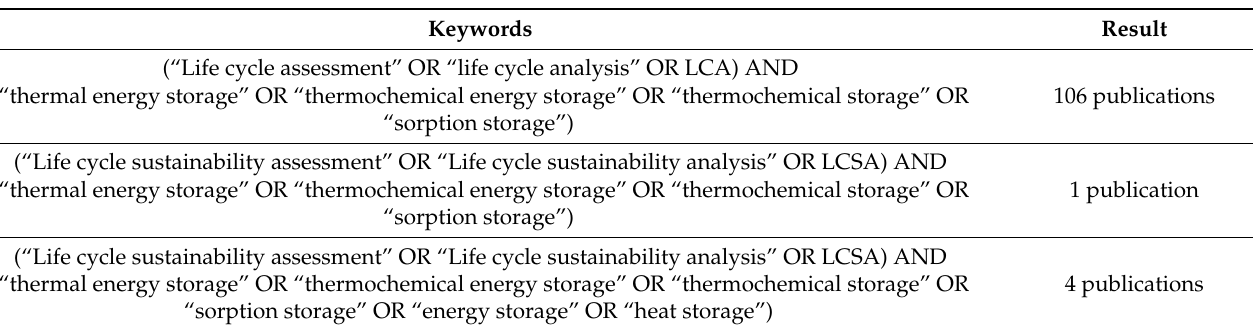
Table 3. Literature search keywords and results.